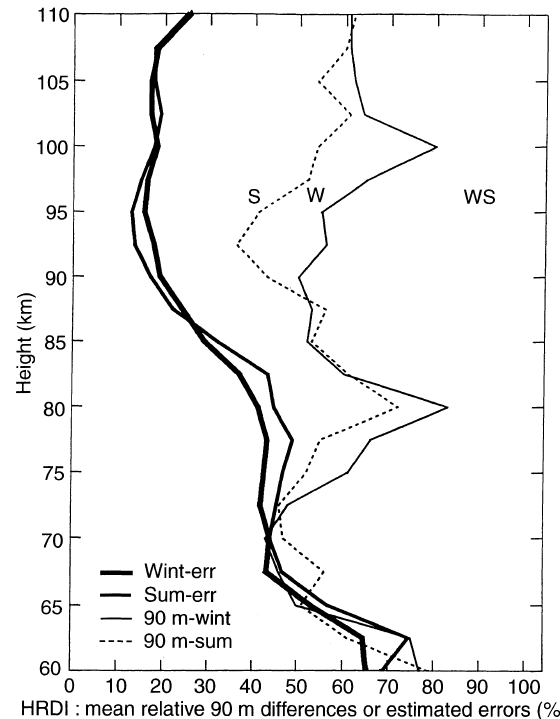
Fig. 7. Saskatoon MFR RMS 90 min di(cid:128)erences for north and east components (from an arbitrary year): summer (labelled 90 m-sum-N , 90m-sum-E ), and winter (labelled 90 m-win-N and 90 m-win-E )